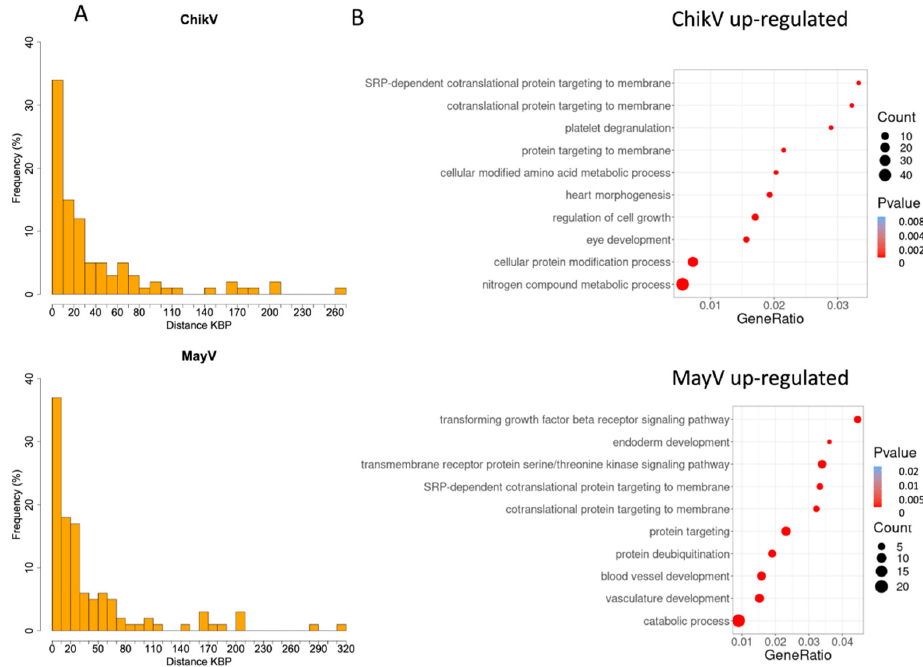
Figure 3. Genome positions and cellular pathways of nearby genes co-modulated by alphaviruses in human primary astrocytes cells. ( A ) Frequencies of the genes co-modulated by HERVs expressed through genomic position in kilobase pairs (KBP) in the alphavirus infections. ( B ) The most enriched GO categories of the nearest genes related to HERVs’ induction by alphaviruses.